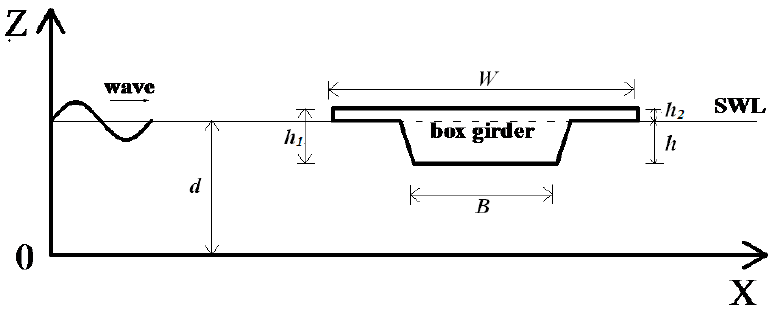
Figure 4. Sketch of the geometry model.